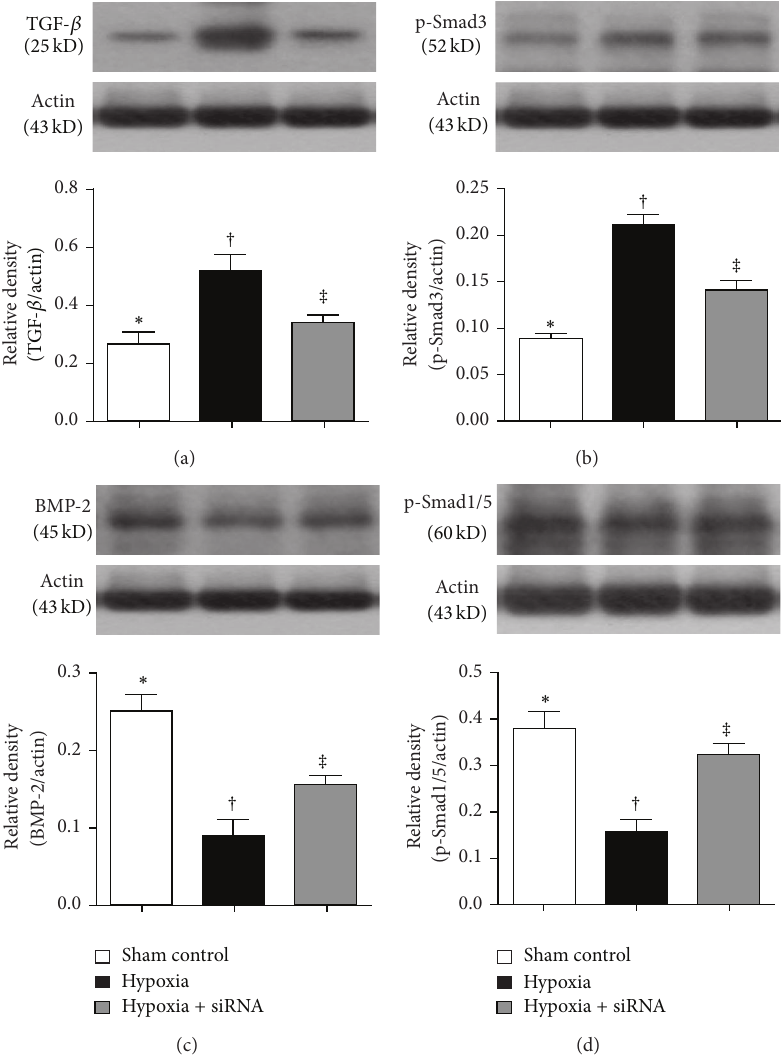
Figure 8: Protein expressions of fibrotic and antifibrotic biomarkers of lung parenchyma by day 28 after hypoxia-induced pulmonary arterial hypertension (PAH) ( 𝑛 = 10 ). (a) Protein expression of transforming growth factor (TGF- 𝛽 ), ∗ versus other groups with different symbols ( ∗ , † , ‡ ), 𝑃 < 0.01 . (b) Protein expression of phosphorylated- (P-) Smad3, ∗ versus other groups with different symbols ( ∗ , † , ‡ ), 𝑃 < 0.001 . (c) Protein expression of bone morphogenetic protein- (BMP-) 2, ∗ versus other groups with different symbols ( ∗ , † , ‡ ), 𝑃 < 0.001 . (d) Protein expression of phosphorylated- (P-) Smad1/5, ∗ versus other groups with different symbols ( ∗ , † , ‡ ), 𝑃 < 0.01 . Statistical analysis in ((a) to (d)) using one-way ANOVA, followed by Bonferroni multiple comparison post hoc test. Symbols ( ∗ , † , ‡ ) indicate significance (at 0.05 level).